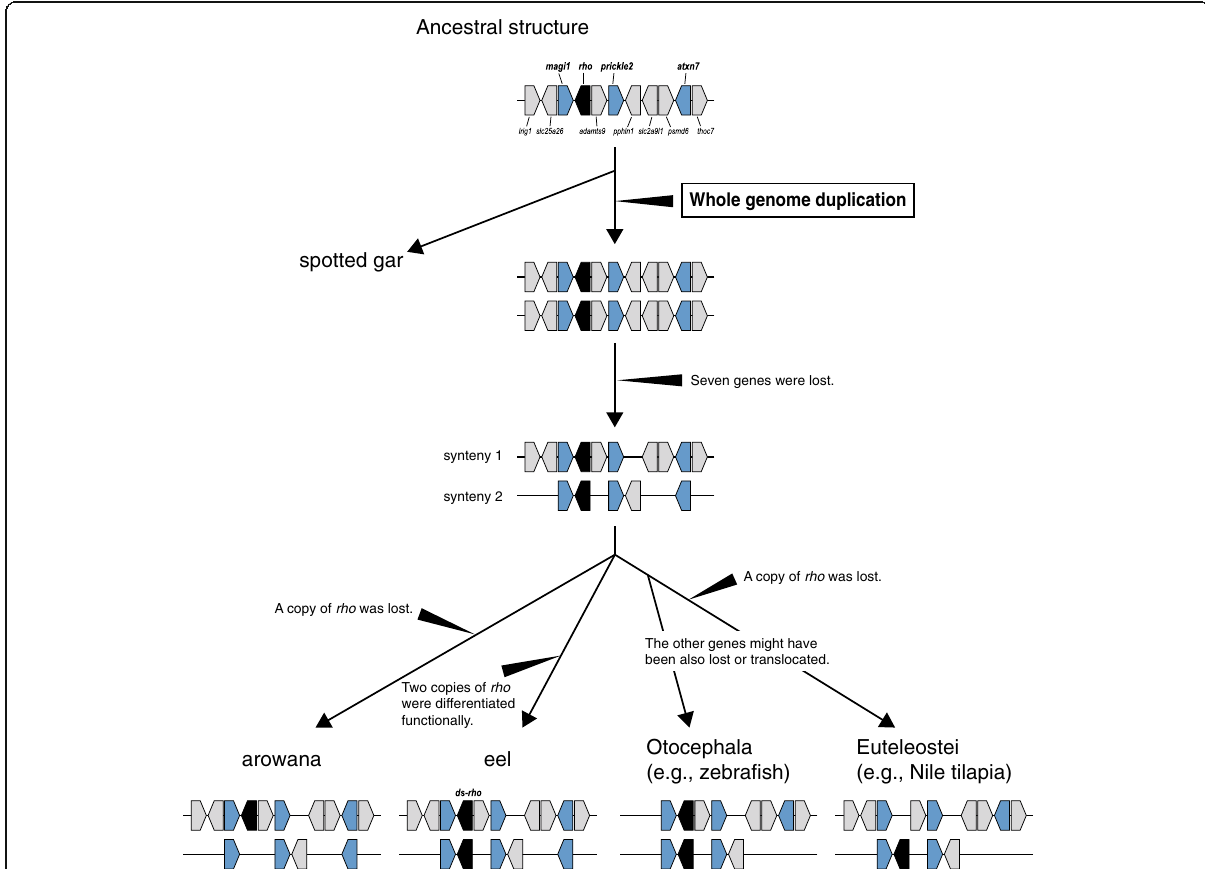
Fig. 5 Evolutionary scheme of rho region in teleostsRhodopsin genes are colored in black, and three pairs of paralogs present in Japanese eel and Asian arowana, magi1 , prickle2 and atxn7 , are highlighted in